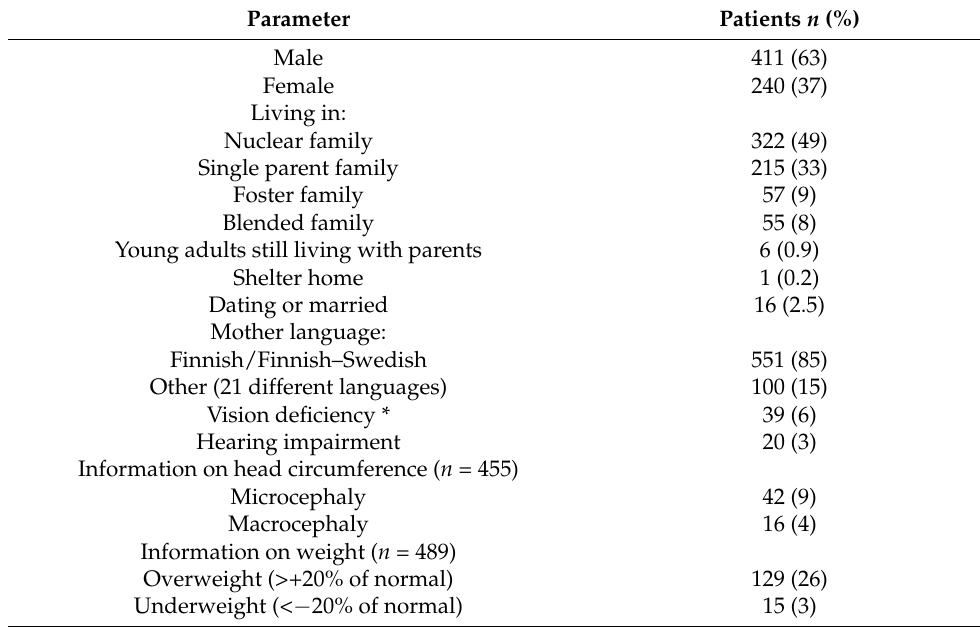
Table 1. Patient demographics of the 651 study